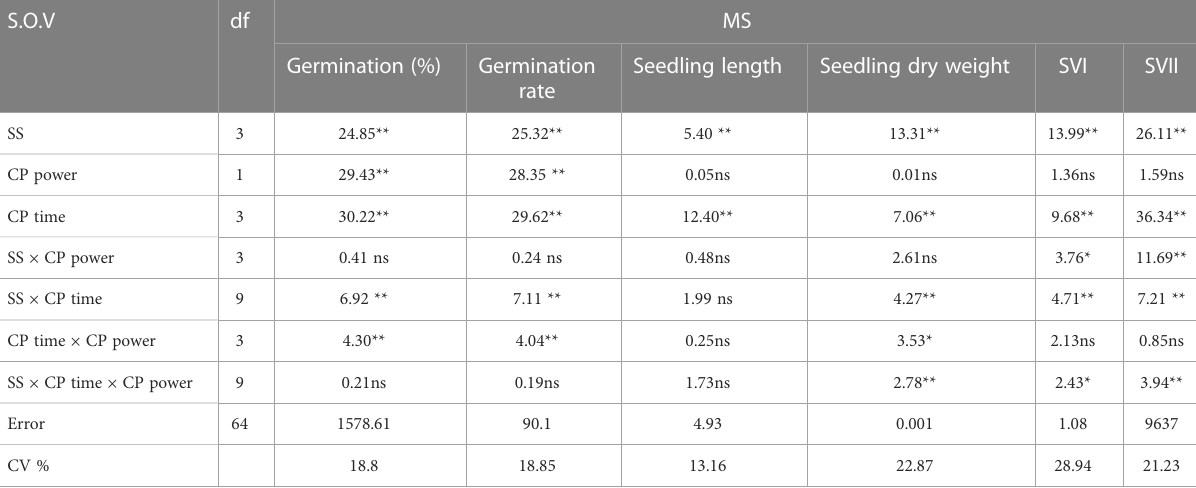
TABLE 1 Variance analysis of the effect of seed situation, cold plasma (CP) power and exposure time of cold plasma on germination percentage and rate, seedling length, and SVI and SVII of S. leriifolia seeds. S.O.V df